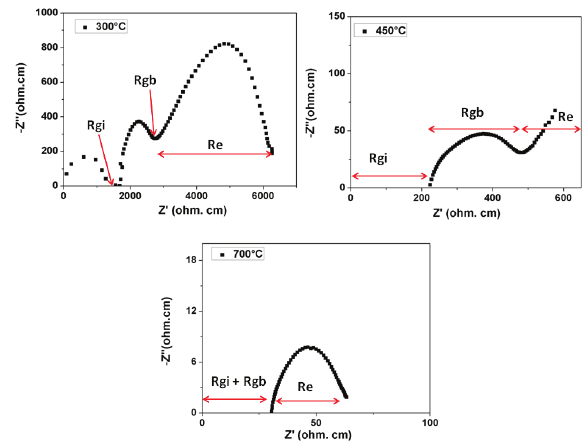
Figure 3: Complex impedance spectra plots of the PSDC9 pellet, measured at 300°C, 450°C and 700°C in air. The grain-interior, grain-boundary and electrode contributions are represented as Rgi, Rgb and Re, respectively.